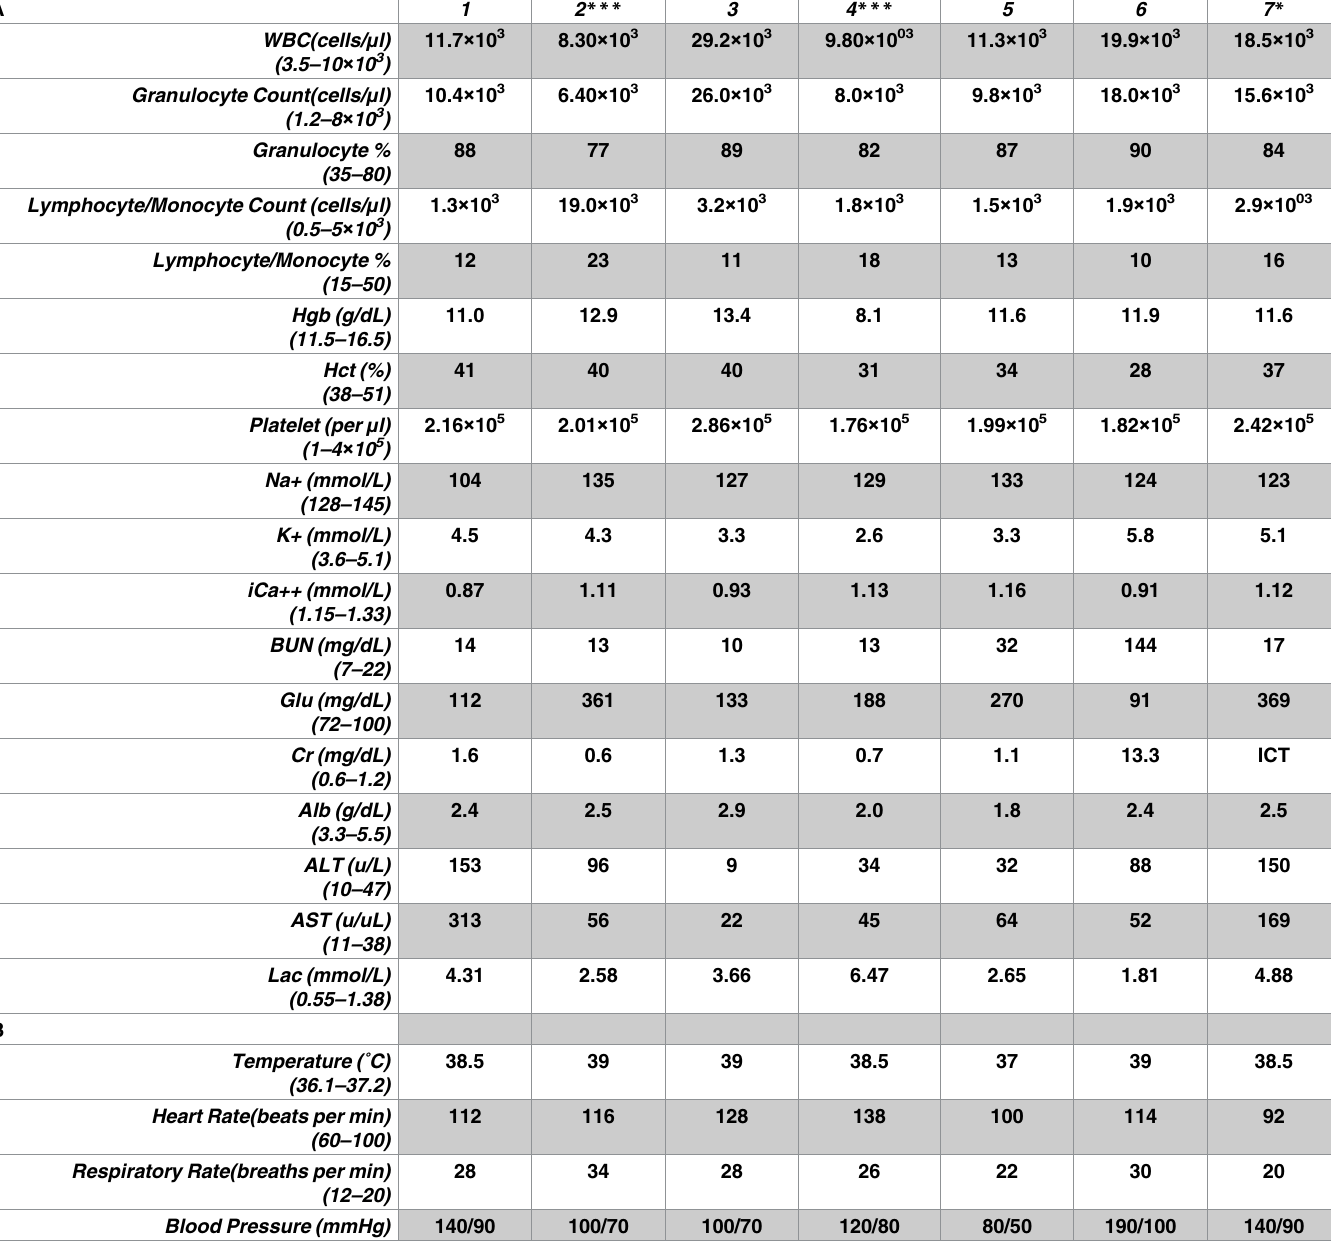
Table 1. Lab results (A) and vital signs (B) collected at enrollment.